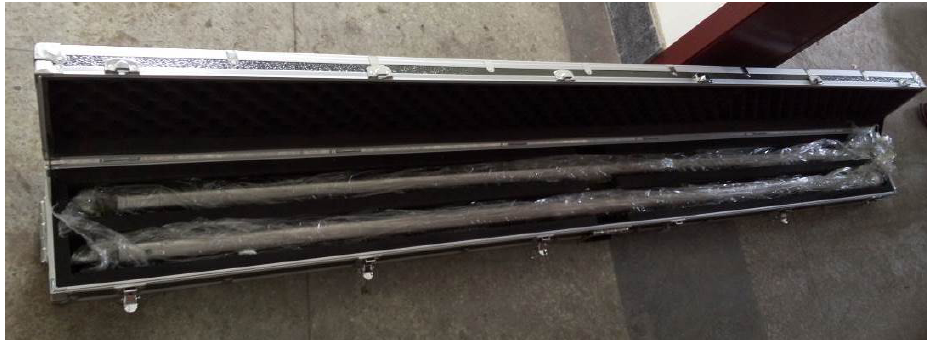
Figure 22. Photo of DTMI which applies to the SK-2 east